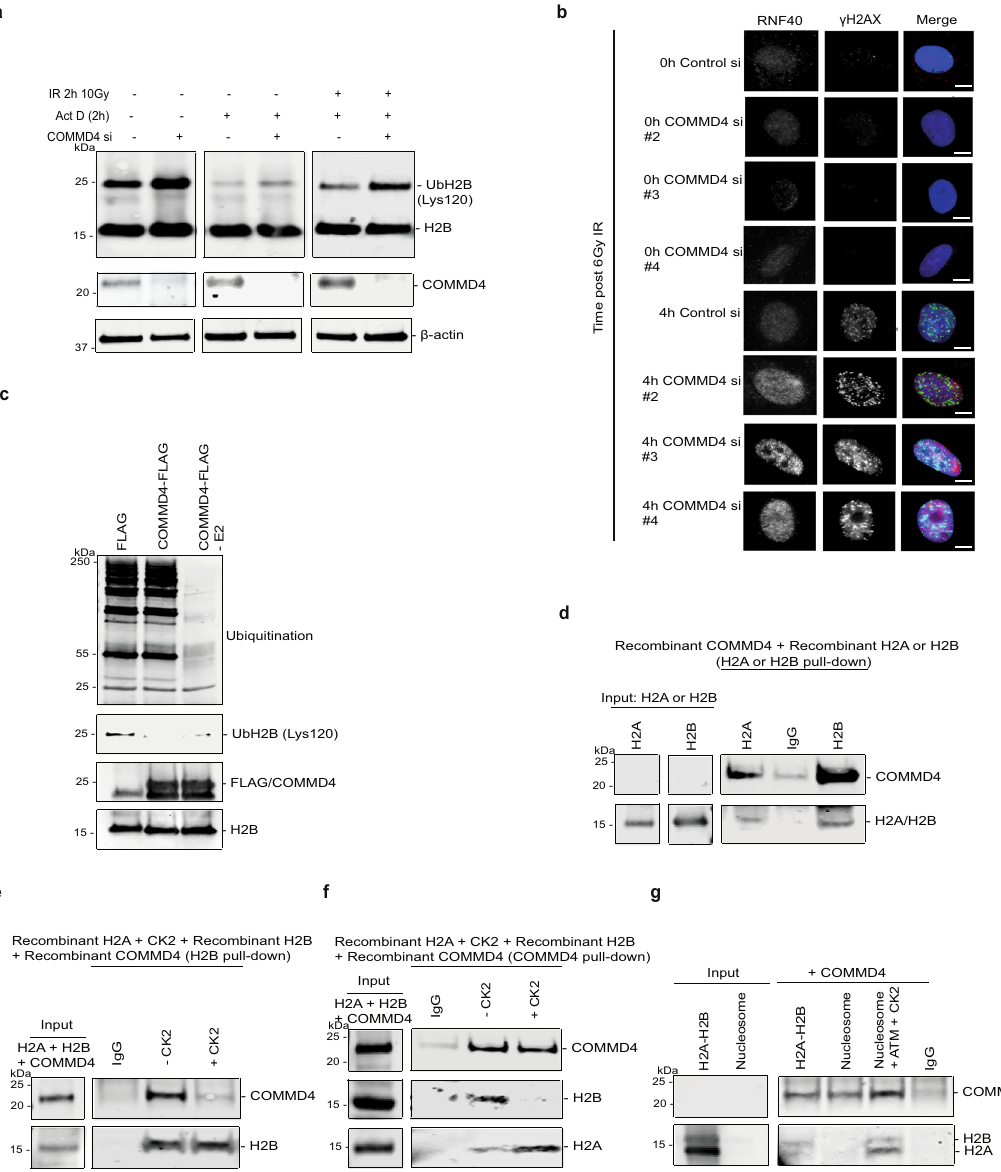
Fig. 4 COMMD4 binds to histone H2A-H2B and regulates the monoubiquitination of H2B. a Immunoblot showing H2B monoubiquitination in control and COMMD4-depleted cells ±5 μ g/ml of Actinomycin D and ±irradiation. b Immuno fl uorescence showing RNF40 protein levels with 6 Gy IR at 0 and 4 h post-IR treatment in control and COMMD4-depleted cells. Scale bar denotes 5 μ m. Fifty cells were quanti fi ed per condition. c In vitro ubiquitination assay of H2B ± recombinant COMMD4 or with COMMD4 and without the E2 enzyme. Monoubiquitination and polyubiquitination of H2B is shown. d Direct interaction between COMMD4 and H2A/H2B, demonstrating that COMMD4 preferentially binds H2B. e In vitro direct interaction between H2A, H2B and COMMD4± recombinant CK2. H2B was used pull-out the complexes and shows loading. f Same as e , however, COMMD4 was used to pull-out the complexes. g Direct interaction between H2A, H2B and COMMD4, in the absence and presence of puri fi ed nucleosomes, ±recombinant ATM and CK2. COMMD4 was used pull-out the complexes and shows the